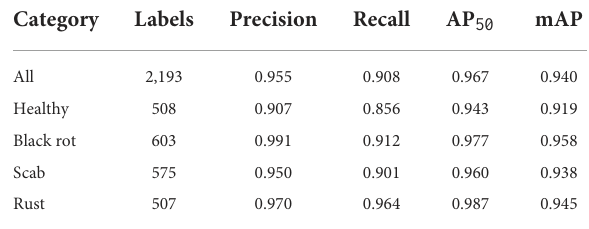
TABLE 2 The detection performance of each